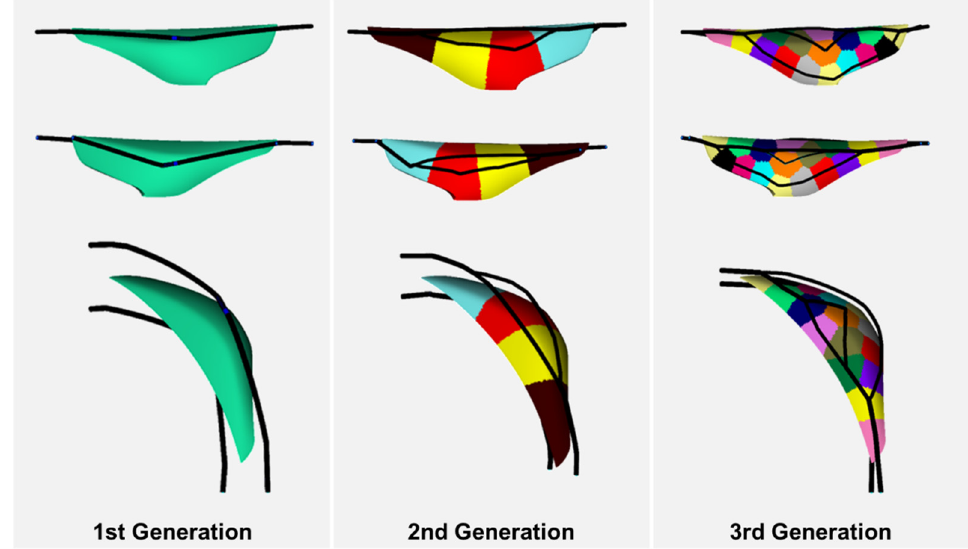
Figure 10. Cooling channel evolution result.